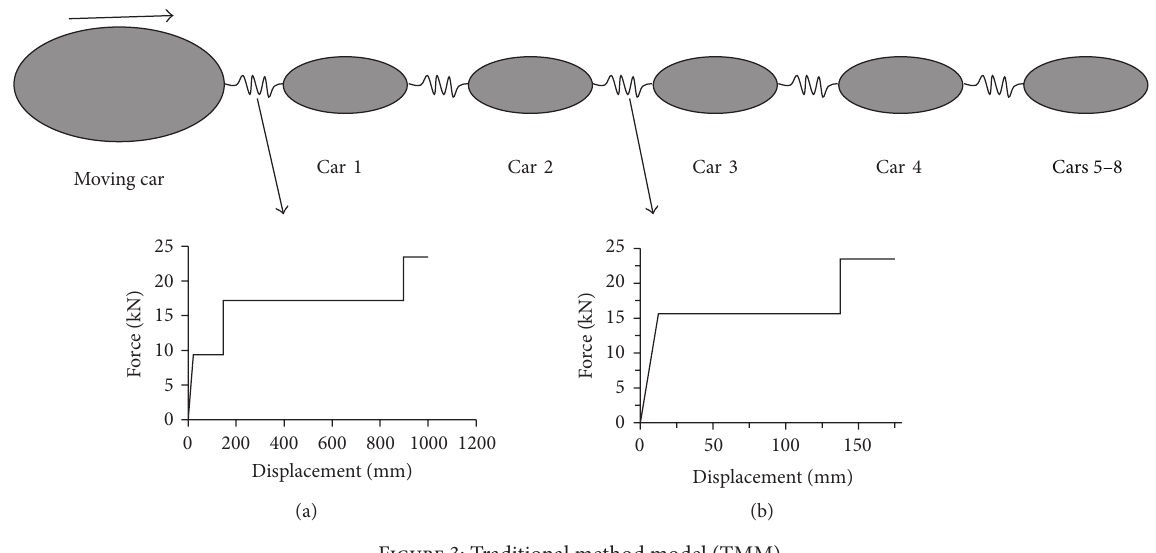
Figure 3: Traditional method model